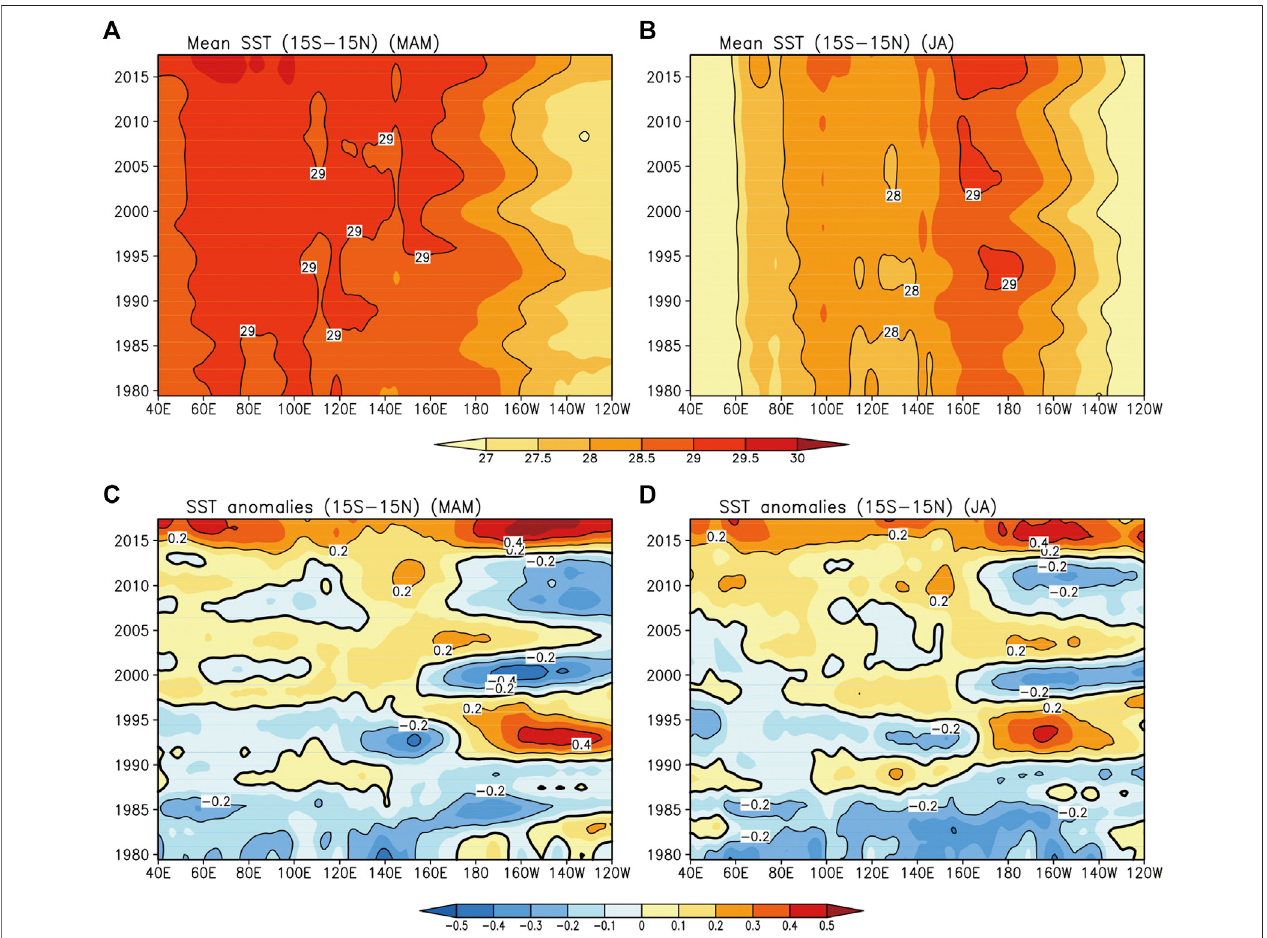
FIGURE 8 | Meridional temporal distributions of mean SST (A, B) and anomalies (C, D) averaged 15 ° S-15 ° N from 1979 to 2017 (contours and shadings, ° C)